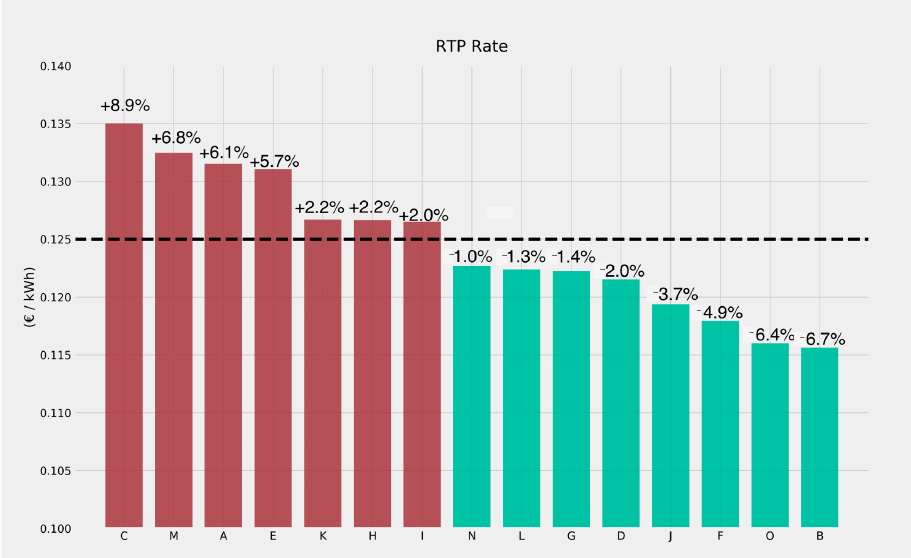
Figure 9. Average hourly cost incurred by an apartment compared to the average hourly rate they